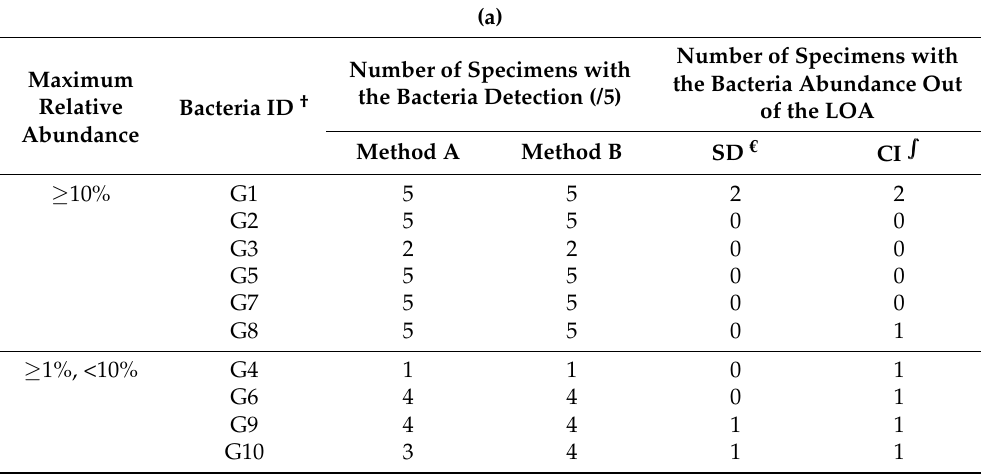
Table 3. Research I: Summary of bacteria detection and Bland–Altman plotting results (Methods